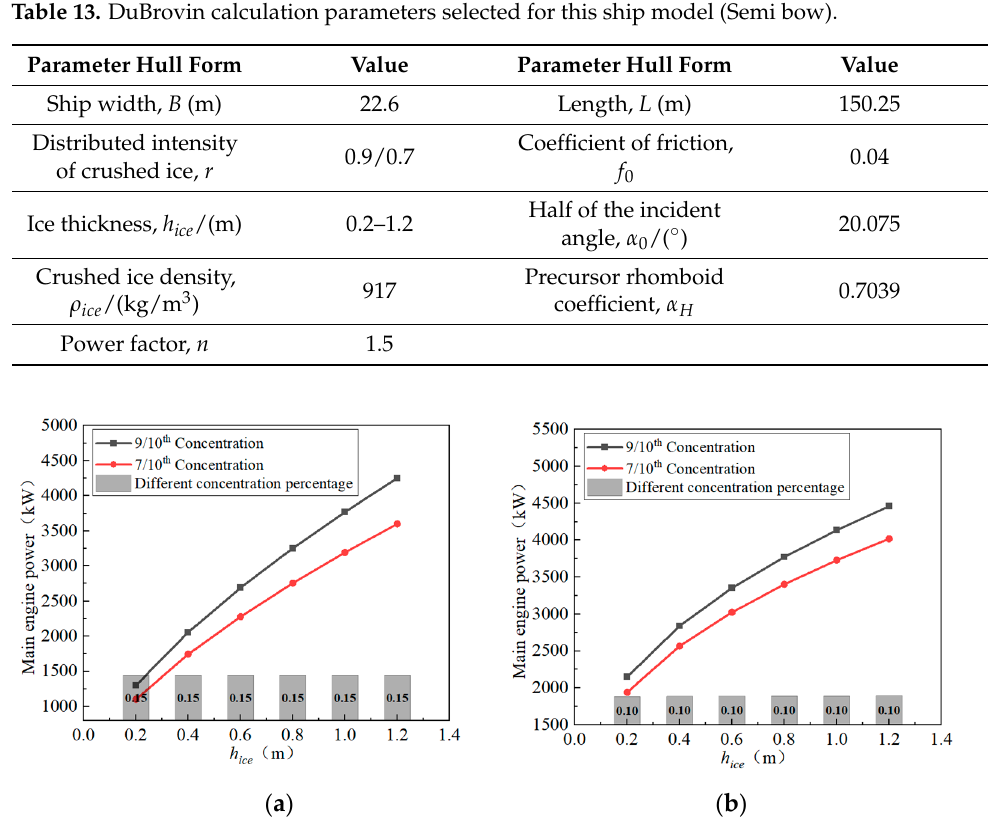
Table 13. DuBrovin calculation parameters selected for this ship model (Semi bow).